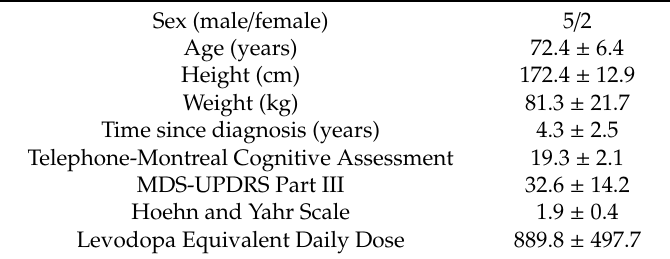
Table 1. Subject demographic information. Data are mean ±